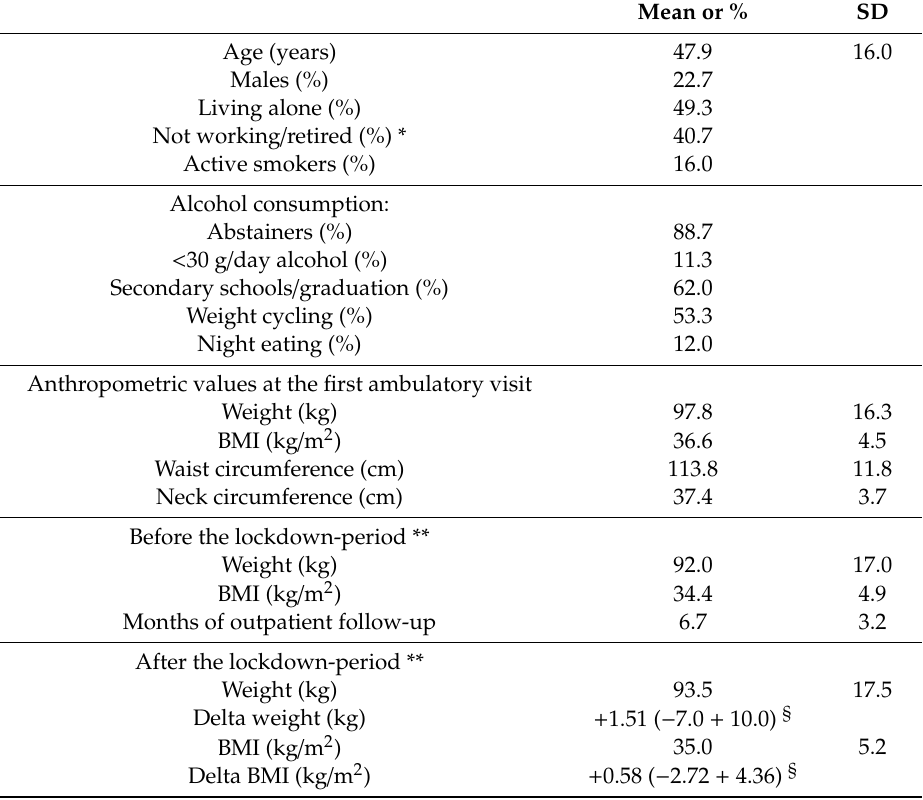
Table 1. Clinical characteristics of participants before and after the lockdown